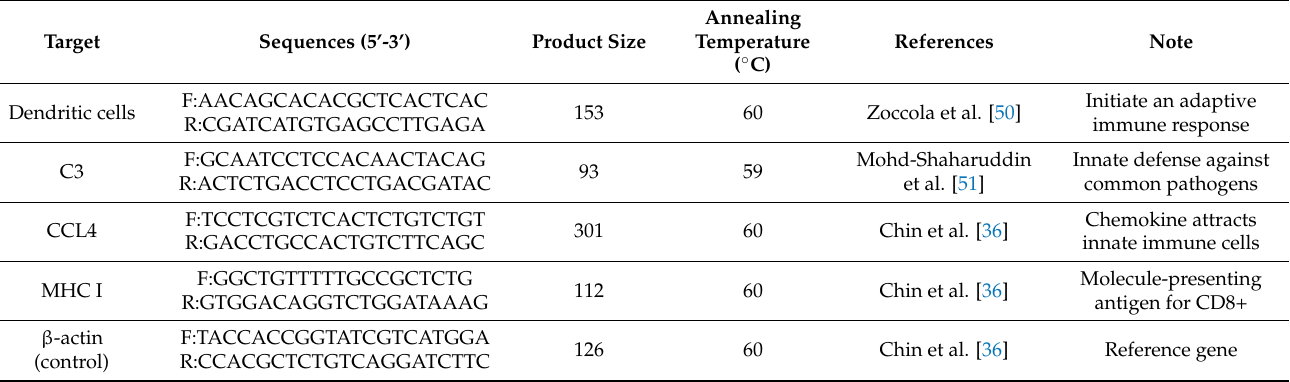
Table 3. Primers used in quantitative real-time PCR